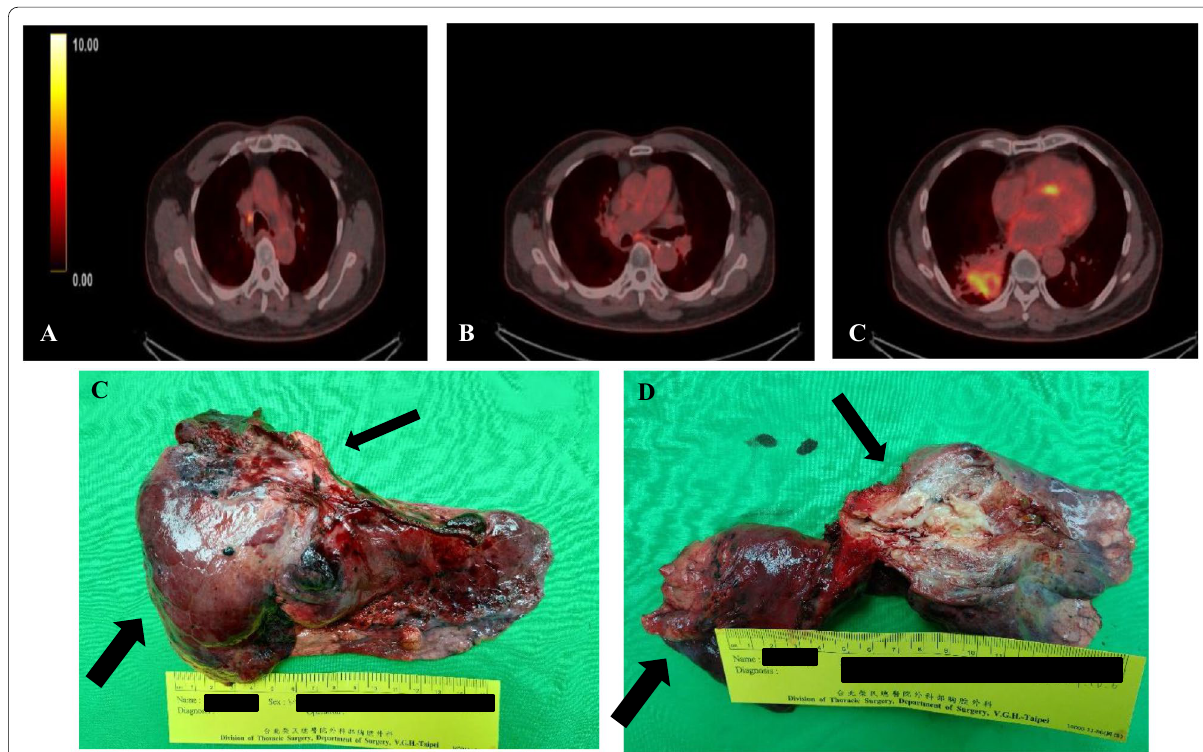
Fig. 4 The preoperative whole body PET demonstrated residual tumor and metastatic lymphadenopathy. a Node with increased uptake in the right lower paratrachea (SUVmax 6.68); b another nodule with increased uptake in subcarina (SUVmax 3.96); c the main tumor (4.3 consolidative mass) with increased uptake (SUVmax 8.03) in the RLL of lung; d surgical specimen of bilobectomy; thin black arrow: simultaneous stapling of PA and bronchus; wide black arrow: RLL tumor mass; E after cutting, the tumor was buried in RLL, about 7 wide black arrow: resected